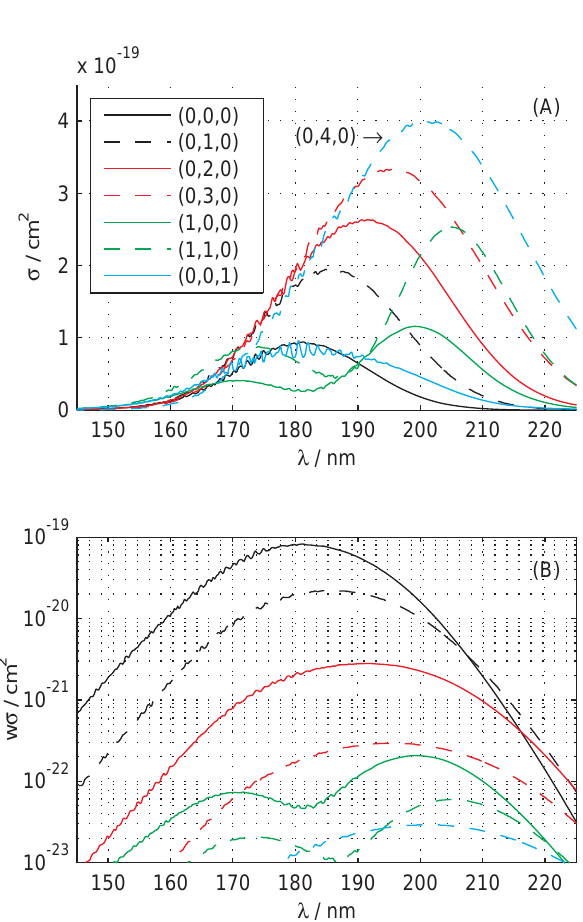
Fig. 2. Panel (A) : The N 2 O cross section for various initial vi- brational states. Panel (B) : Cross sections for the various initial states multiplied by the Boltzmann weighting factor w i = Q − 1 ( 1 + v 2 ) exp ( − E i /(k B T )) with T = 300K and Q being the partition